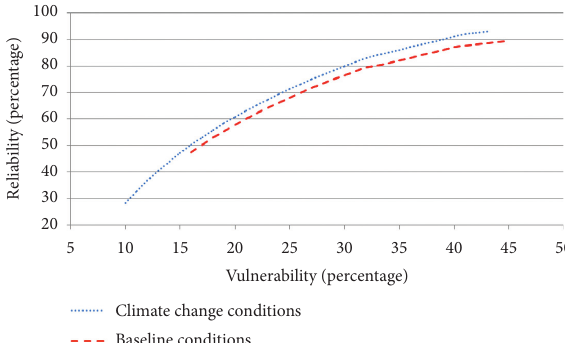
Figure 6: The comparison of the Pareto curve and changes in vulnerability and reliability objective